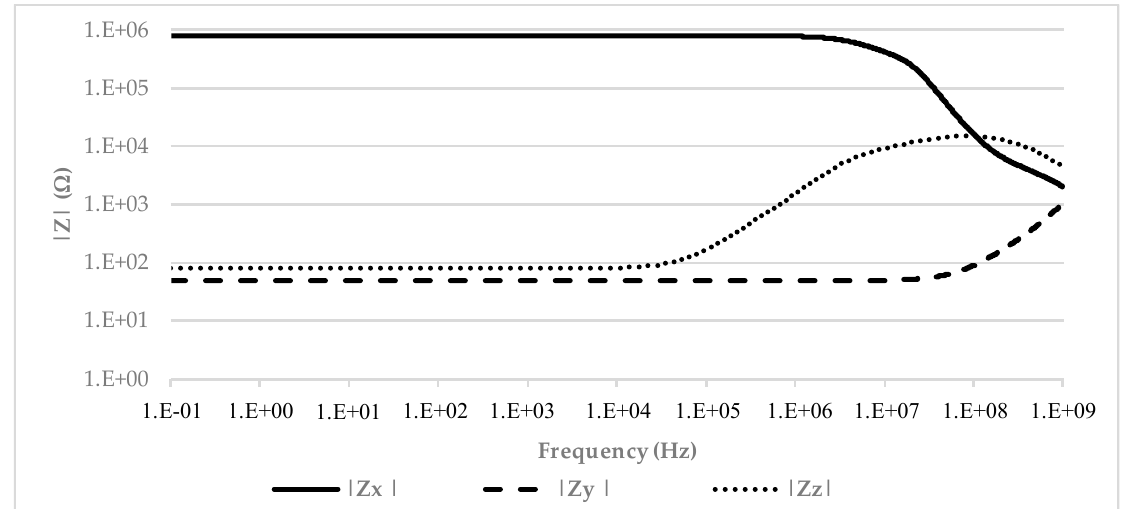
Figure 3. VCII impedances vs. frequency behavior.